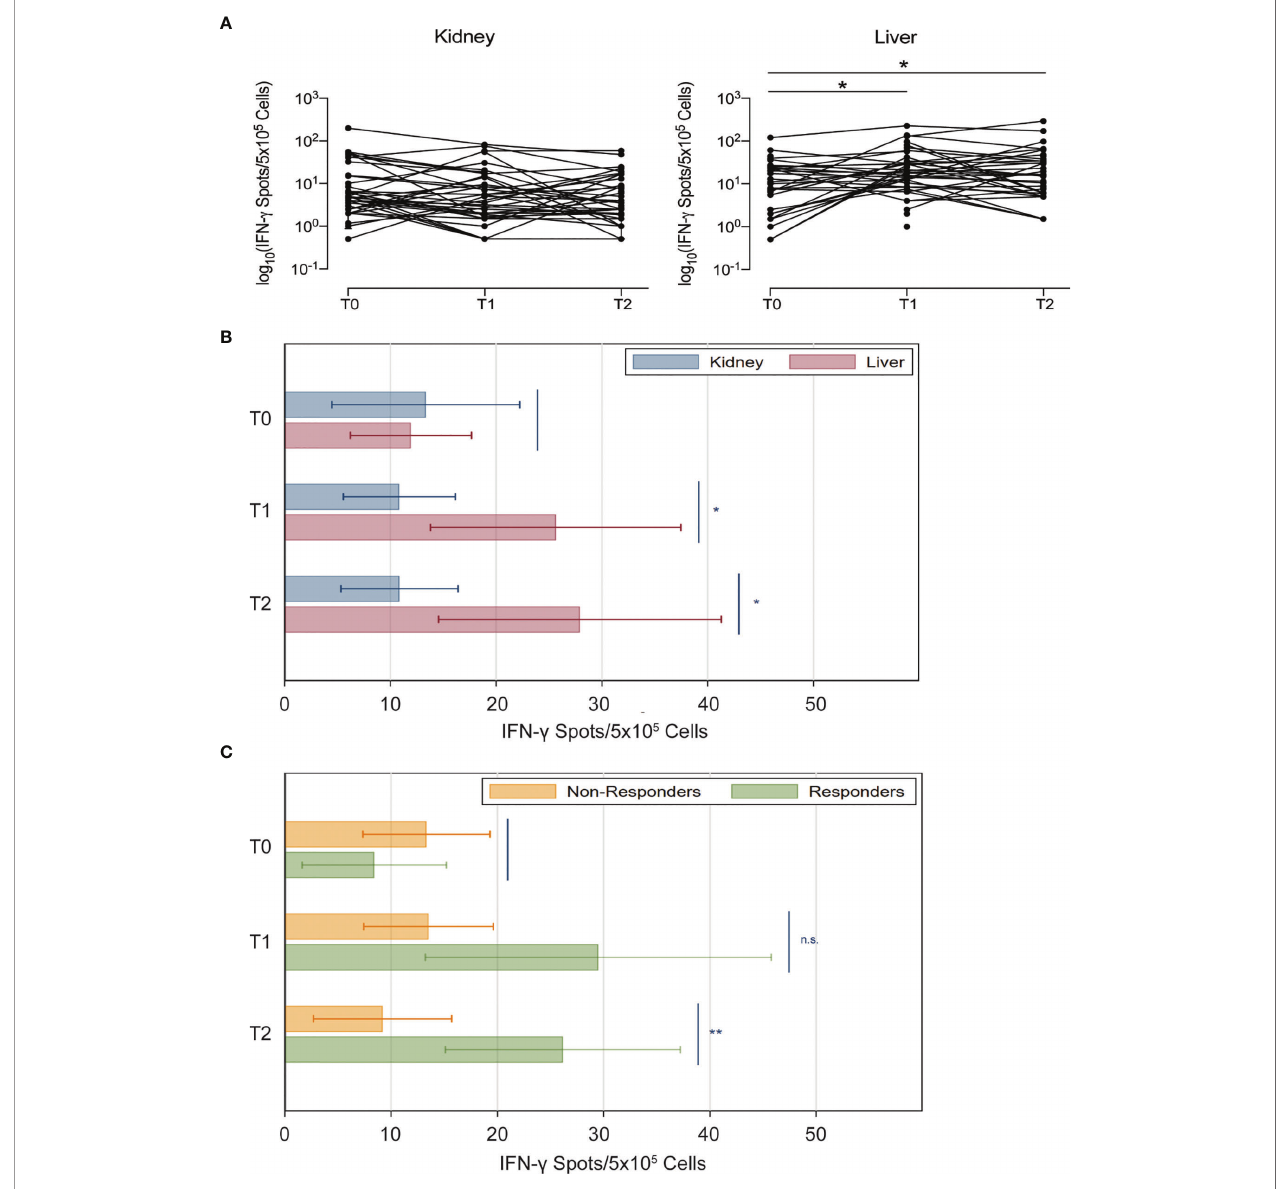
FIGURE 4 | Anti-spike IFN- g + T cell responses in kidney and liver transplant recipients after SARS-CoV-2 vaccination. (A) Anti-spike IFN- g + T cell spots of individual subjects (natural logarithmic scale). (B) Number of spots of anti-S IFN- g FluoroSpot in kidney (blue) and liver (red) transplant recipients at each time point. (C) Analyses shown in panel B were repeated after stratifying patients based on anti-RBD antibody response (MFI threshold for positivity: 8880) (kidney and liver transplant recipients have been pooled together for this analysis). Horizontal lines represent 95 percent con fi dence intervals n.s., not signi fi cant; *P < 0.05, **P <